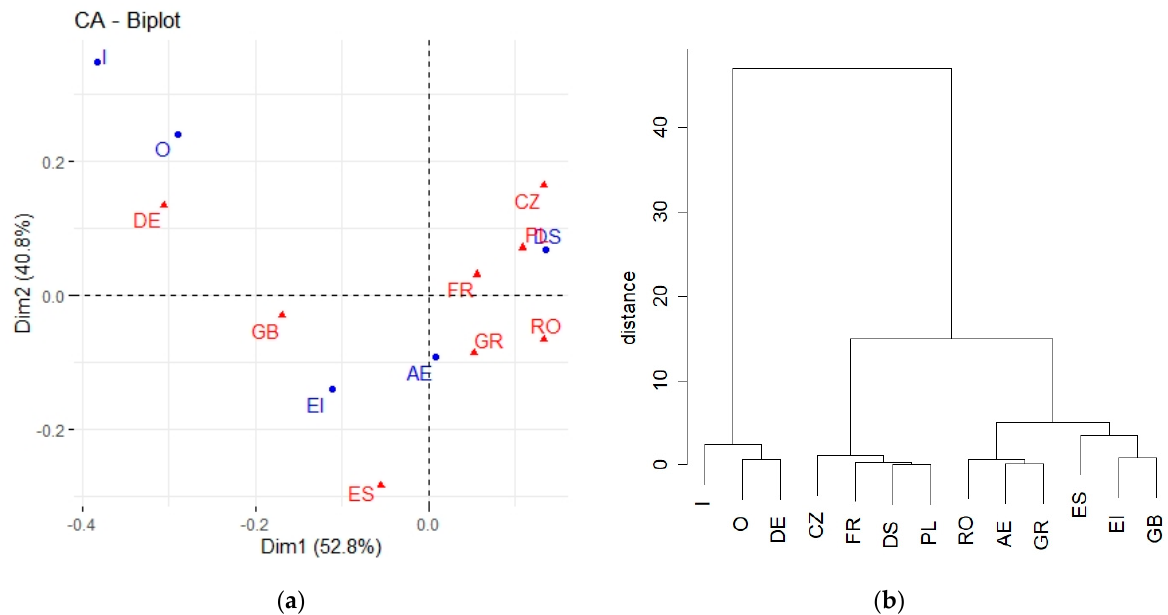
Figure 4. Correspondence map ( a ) and an auxiliary dendrogram ( b ) showing the dependence of each behavioural type of energy consumer on their country of residence.